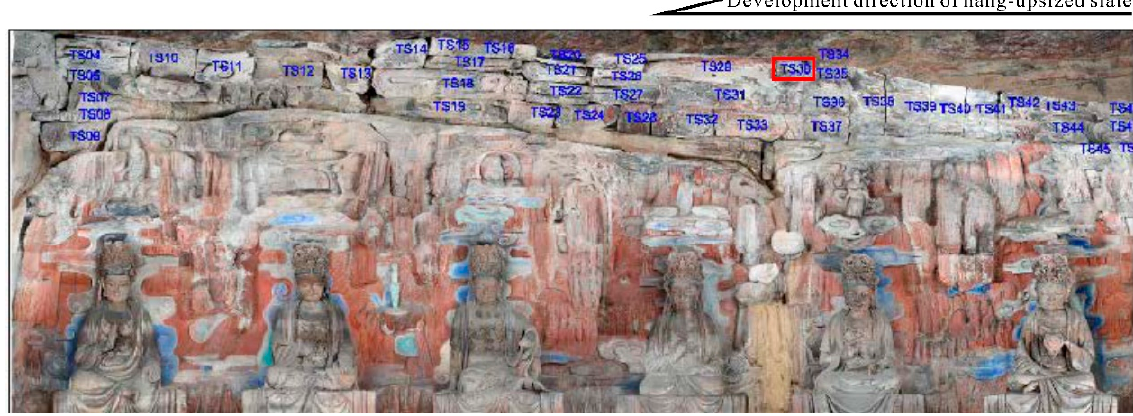
Figure 12. Early warning point for instability of overhanging rocks. 4.2. Analysis of the E ff ect of Slate Crushing on the Force Deformation of the Roof Slab The analysis scheme was used to increase the number of broken slates in sequence from the light hole to the direction of the J10 drainage place behind Yuanjue Cave and simulated the change of the number of broken- slates by changing the slate structure relationship. Figure 13 shows the vertical displacement of the roof slab of Yuanjue Cave under the action of di ff erent crushed rocks. With the increase in the number of crushed rocks, the roof slab of Yuanjue Cave underwent uneven se tt lement, and the maximum se tt lement position was shifted from the central area to the left front of Yuanjue Cave (the side of crushed rocks), and continuously developed to the left rear side. The above analysis shows that the number of broken boulders has a significant influence on the force deformation and stability of the roof slab of Yuanjue Cave.